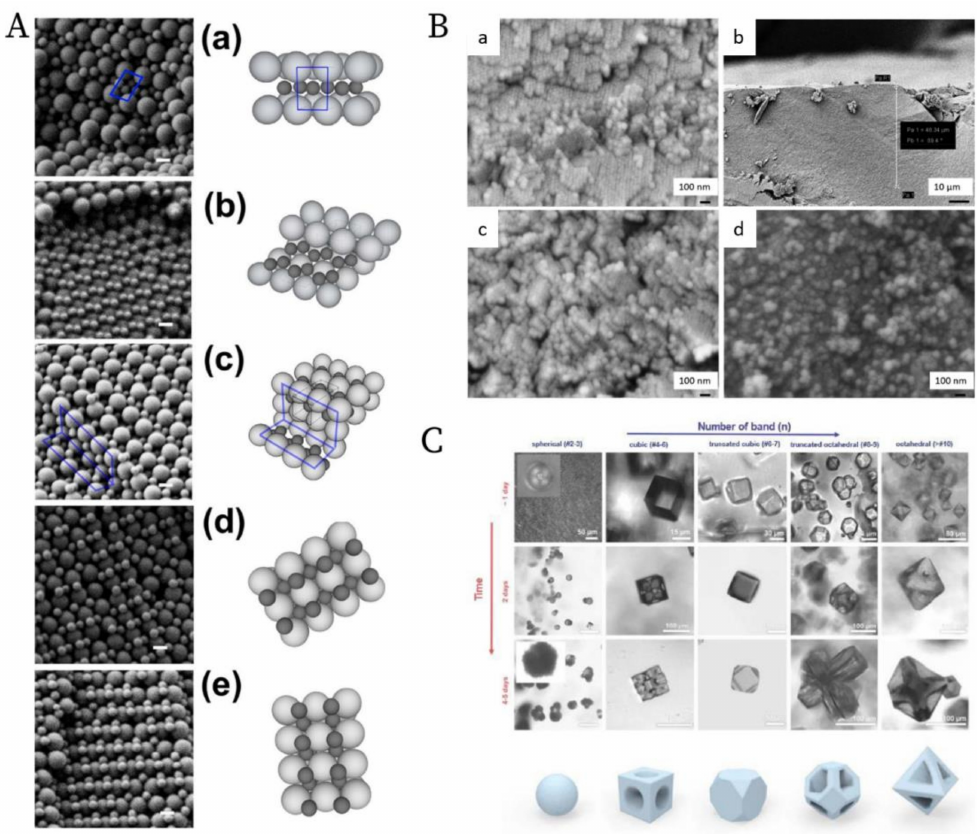
Figure 13. ( A ). SEM images and schematics of the corresponding binary crystal lattices at different radial positions for a binary mixture of 150 nm and 300 nm latex nanoparticles after the PUC: ( a ) layered structure akin to AlB2; ( b ) distorted AlB2 structure; ( c ) the tetragonal A3B variant; the tetragonal A2B variant before ( d ) and after distortion ( e ). Scale bars = 200 nm; ( B ). SEM images at different radial positions for a binary mixture of 30 nm and 40 nm silica nanoparticles after the PUC: ( a ) Representative image of a crystalline structure in the upper part of the sediment; ( b ) Overview of the transition position where the last piece of crystalline structure was observed ( ≈ 50 µ m from the meniscus); ( c ) Representative zoom-in image of the transition position where only discrete small pieces of crystalline structures were observed. ( d ) Representative image of a glassy structure below the transition position; The crystal to glass transition agreed with the previous study [151]; ( C ). Confocal microscopy images of the morphology evolution of the MOF-crystal in the precipitation bands at different positions (horizontal axis) due to the concentration gradients of both metal ions and ligands, and at different time (vertical axis). Reproduced with permission from [107], Copyright the American Chemical Society, 2015, [103], Copyright the American Chemical Society, 2019 and [148], Copyright Wiley-VCH,